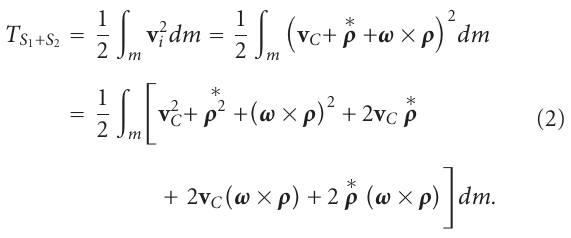
Figure 5: Beams with the same bending elasticity.